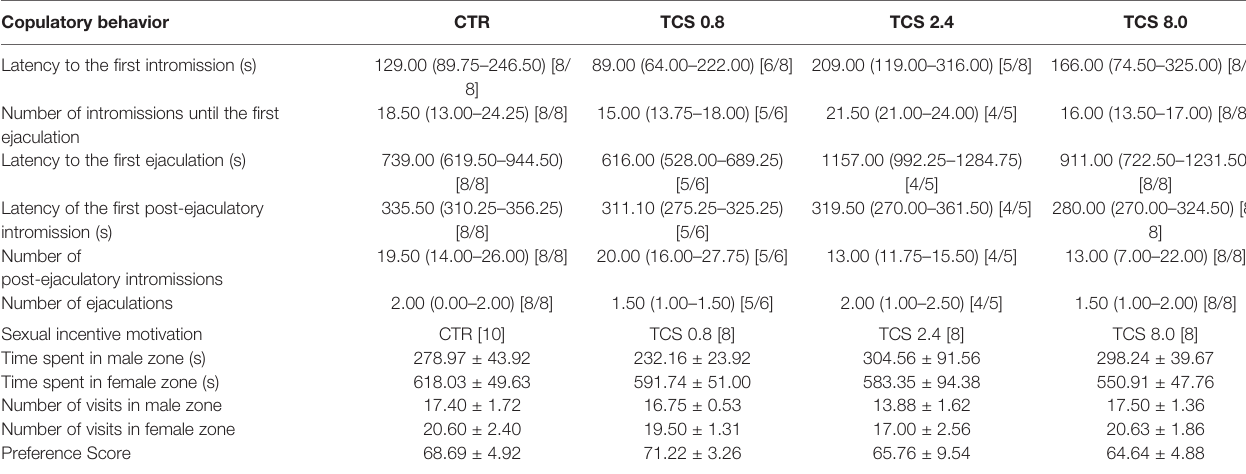
TABLE 1 | Sexual behavior of male rats of F1 generation at PND